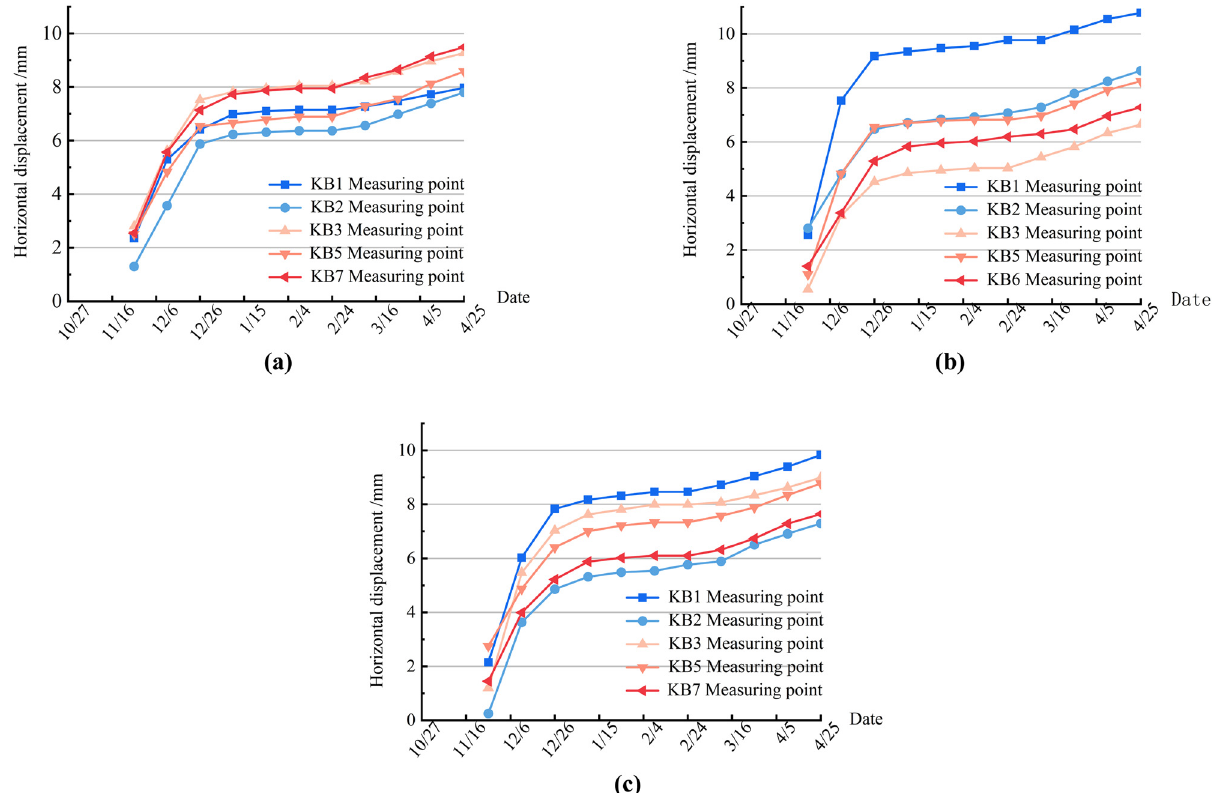
Figure 5: Horizontal displacement at di ff erent depths of the supporting structure. ( a ) 5 m deep, ( b ) 15 m deep, and ( c ) 20 m